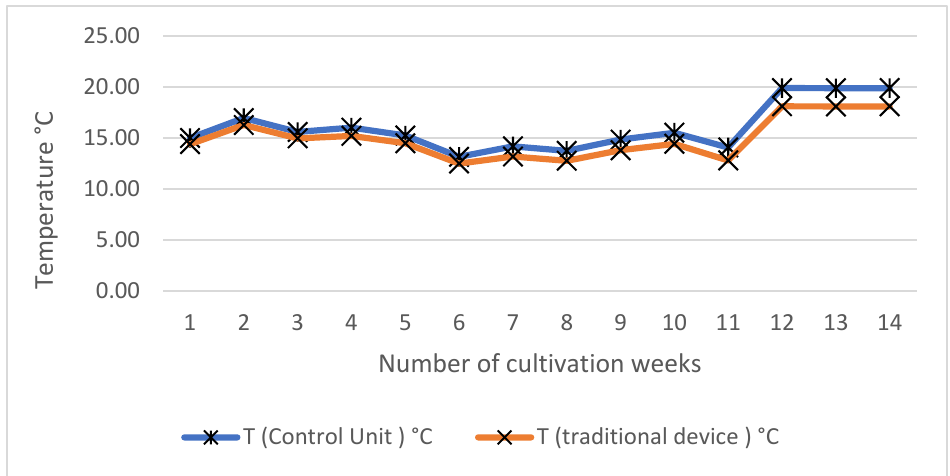
Figure 5. Results of IT from an Arduino microcontroller system and traditional devices by week.